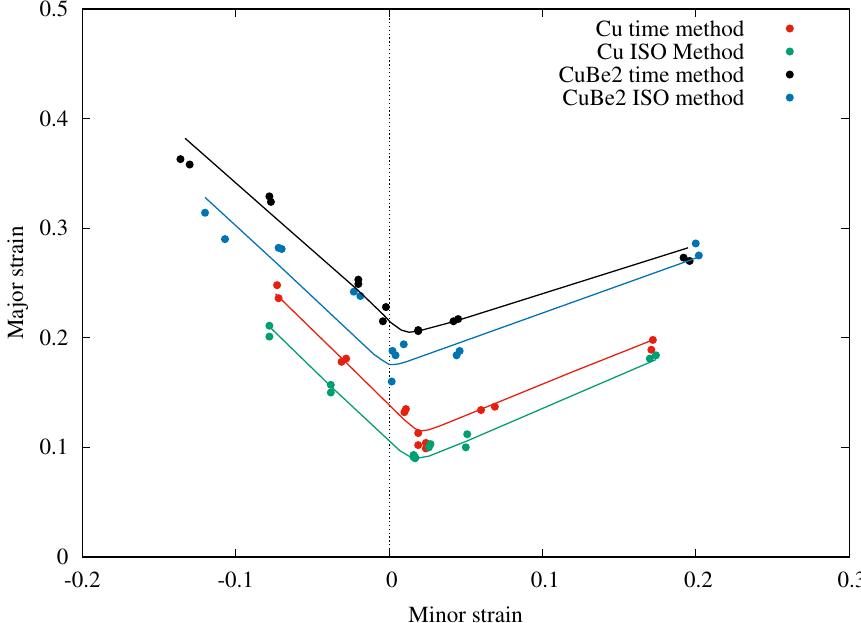
Figure 10. Forming limit curves of pure Cu and CuBe2 alloy: comparison of ISO-12004 and time-dependent